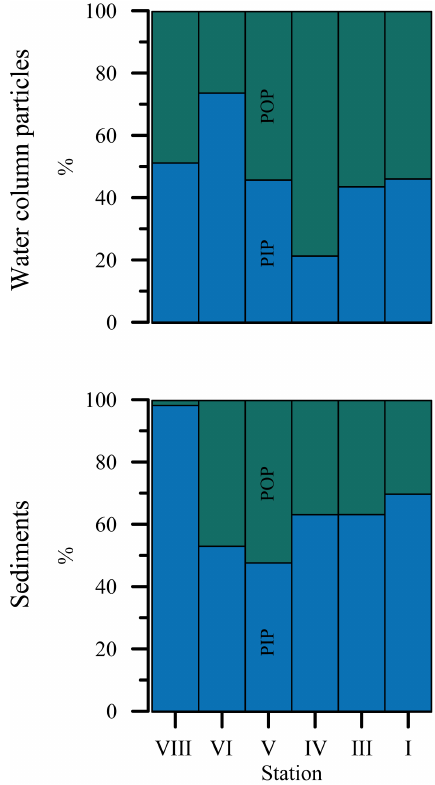
Figure 3. Average distribution of POP and PIP (%) per station in the water-column particles and in the top 5.5cm of the